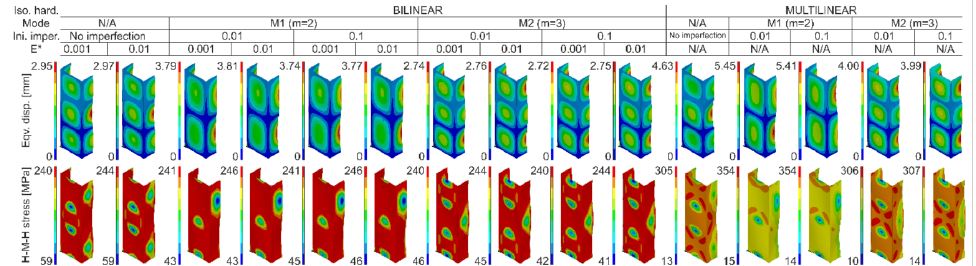
Figure 8. Contour maps of equivalent displacements and H-M-H stresses for maximum compressive forces.